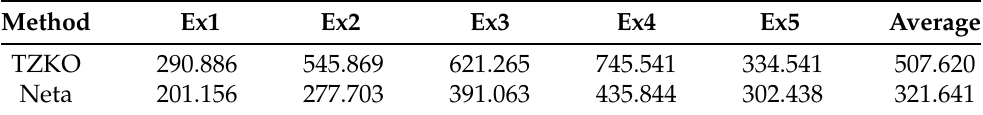
Figure 1. Our method (left) and TZKO (right) for the roots of the polynomial q ( z ) (10). Table 2. CPU time (msec) for each example (1–5) and each of the methods. 9.